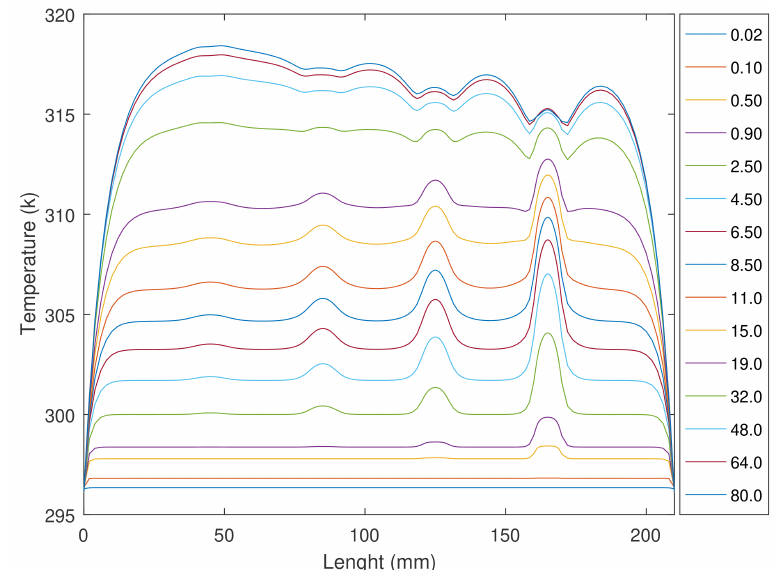
Figure 8. Temperature profiles in the stimulation surface after 15 cycles for cycle periods of 0.02, 0.10 up to 80 s.